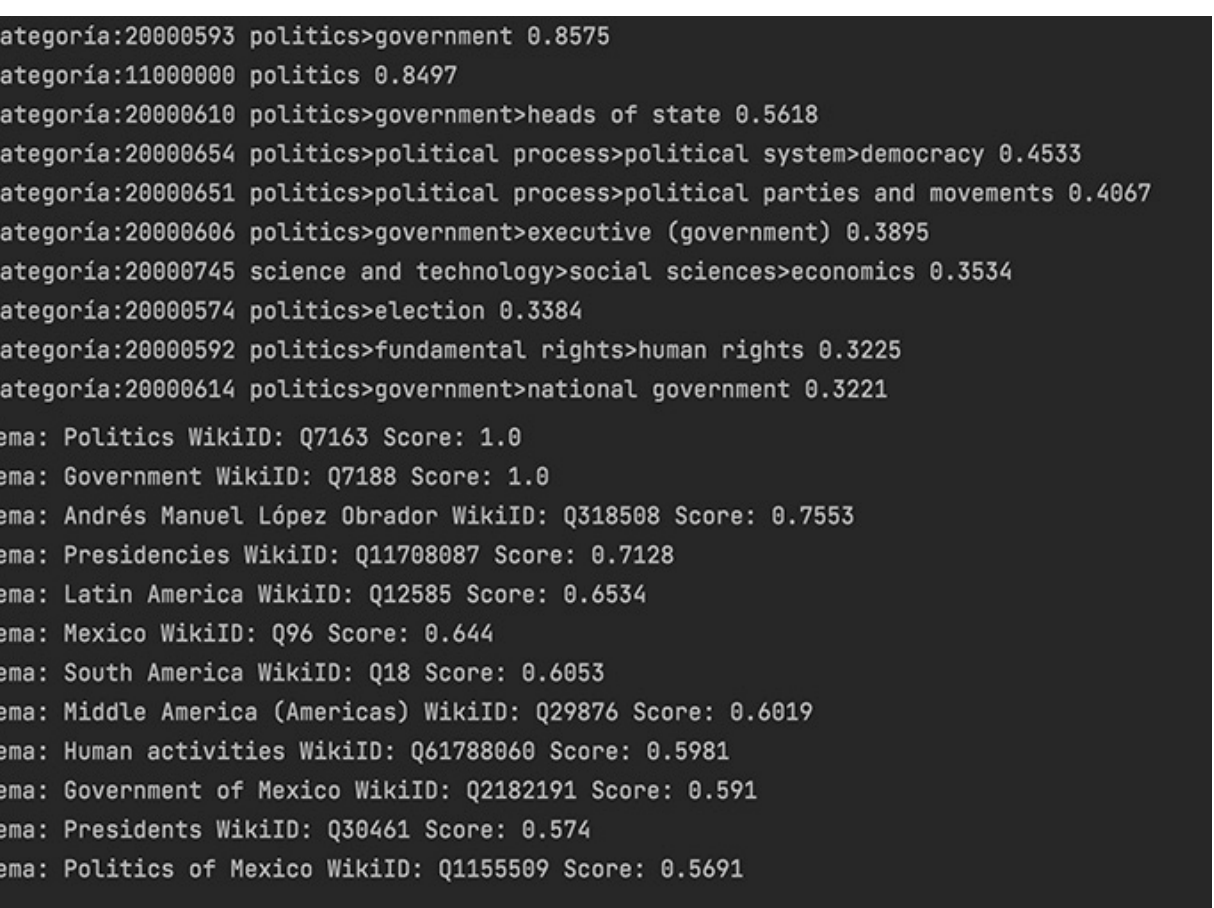
Appl. Sci. 2022 , 12 , x FOR PEER REVIEW 13 of 20 Figure 4. NER and relation extraction results (partially in Spanish; 'Entidad' stands for 'Entity'). Figure 4. NER and relation extraction results (partially in Spanish; ’Entidad’ stands for ’Entity’).